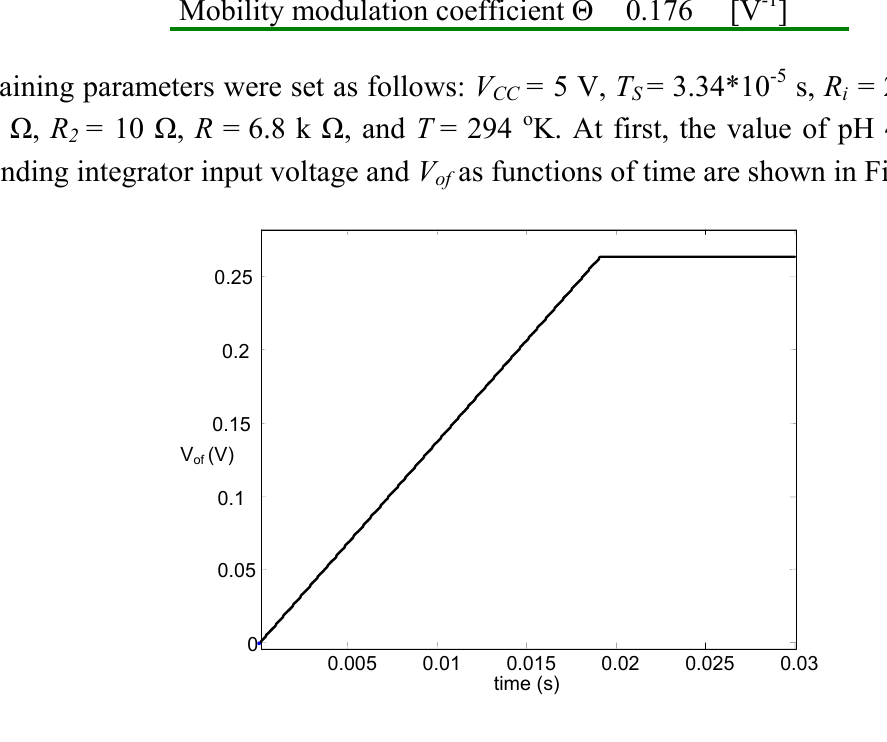
Figure 6 . Output voltage of resistive divider as a function of